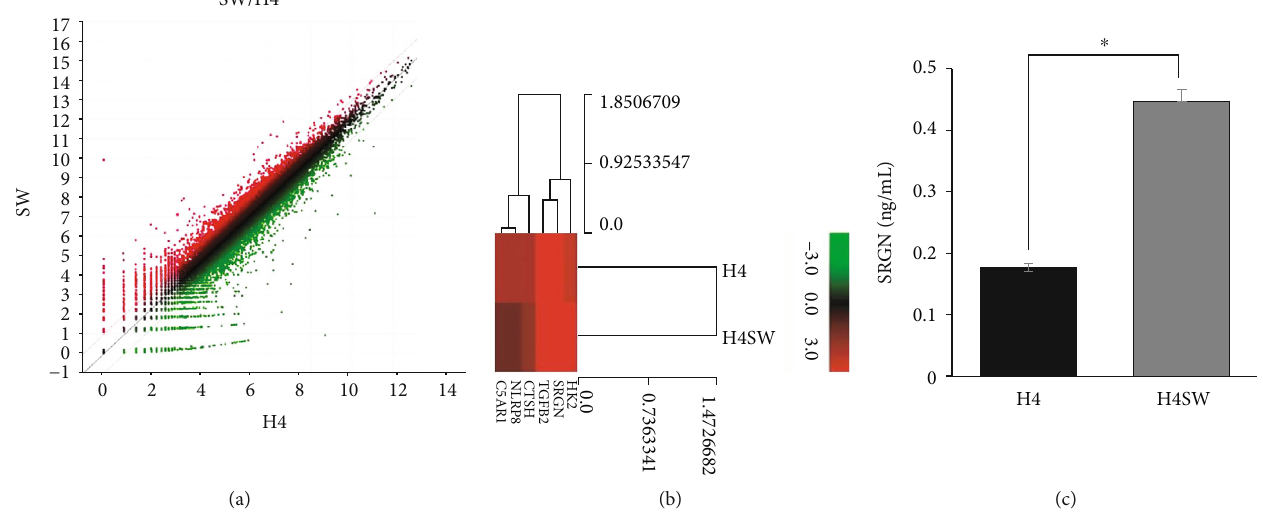
Figure 7: Identi fi cation of SGRN as a secretory protein of H4SW cells. The gene expression patterns of H4SW cells were upregulated compared to H4 cells. (a) Scatter plot and (b) Euclidean distance clustering of signi fi cant genes performed by MeV software are presented as log-transformed data. The green and red colors indicate decreased and increased gene expression, respectively. (c) ELISA assay of SRGN concentrations in H4 and H4SW cell cultures. Three samples per experimental group were tested in each assay. The data are presented as the mean ± S : E : M . ∗ p < 0 : 05 .